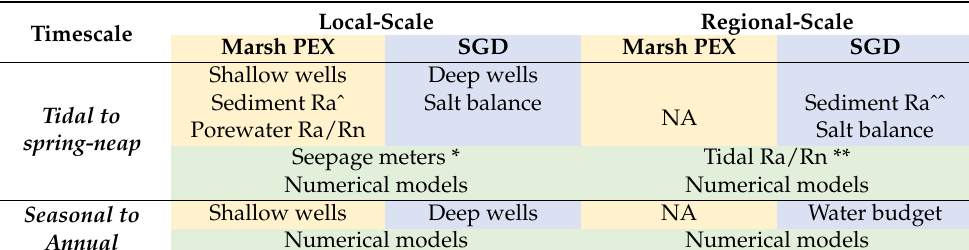
Table 1. Summary of methods used to quantify marsh PEX (yellow shading) and SGD (blue shading), arranged by approximate spatial and temporal scales. Several methods capture both marsh PEX and SGD (green